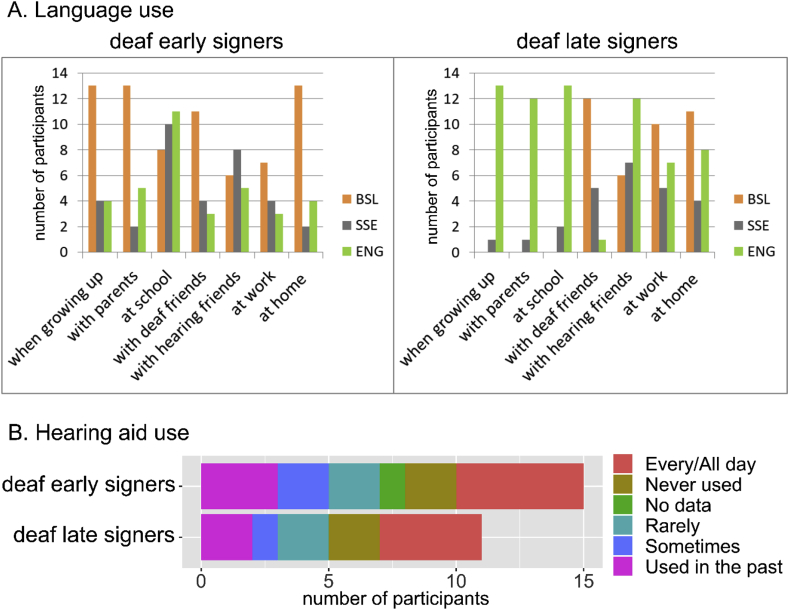
Additional background information on the deaf signers. A: language use in everyday life. BSL = British Sign Language; SSE = Sign Supported English; ENG: spoken English. Many participants selected more than one language in a given situation. B: Hearing aid use.